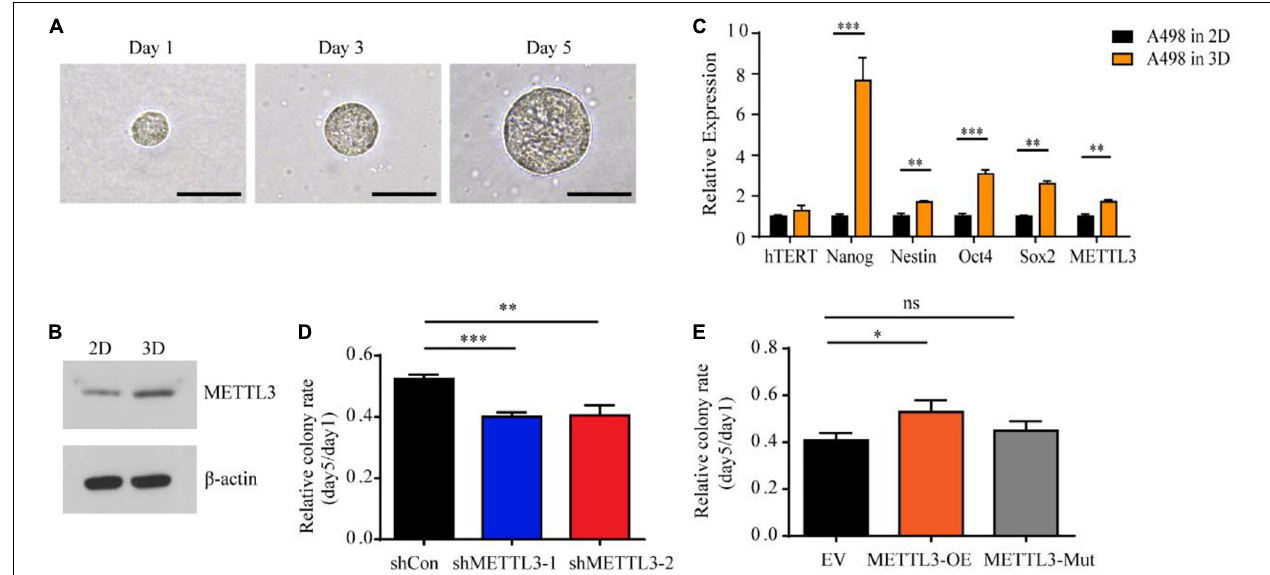
FIGURE 3 | Upregulation of stem cell-associated genes including METTL3 in A498 spheroid cells cultured in 3D fibrin gel. (A) A single A498 cell grew into a multicellular tumor spheroid within a 90 Pa 3D fibrin gel during the culture course from Day 1 to Day 5 (scale bar, 500 µ m). (B) The protein level of METTL3 from A498 cells cultured in 2D rigid dishes or 90 Pa fibrin gels was examined by western blot. β -actin was used as a loading control. (C) Stem cell markers and hTERT expression in A498 cells were quantified by RT-qPCR. The same mRNA sample of A498 tumor spheroid cells was used as above. A498 cells cultured in 2D rigid dishes were used as controls. Mean ± SD, * p < 0.05, compared with the 2D cells. (D,E) Sphere formation analysis of A498 cells transduced with METTL3-targeting virus (D) and METTL3-expressing virus (E) , normalized to the number of spheroid cells at day 1. Error bars represent the SD of the mean ( n = 3). ** P < 0.01, *** P <